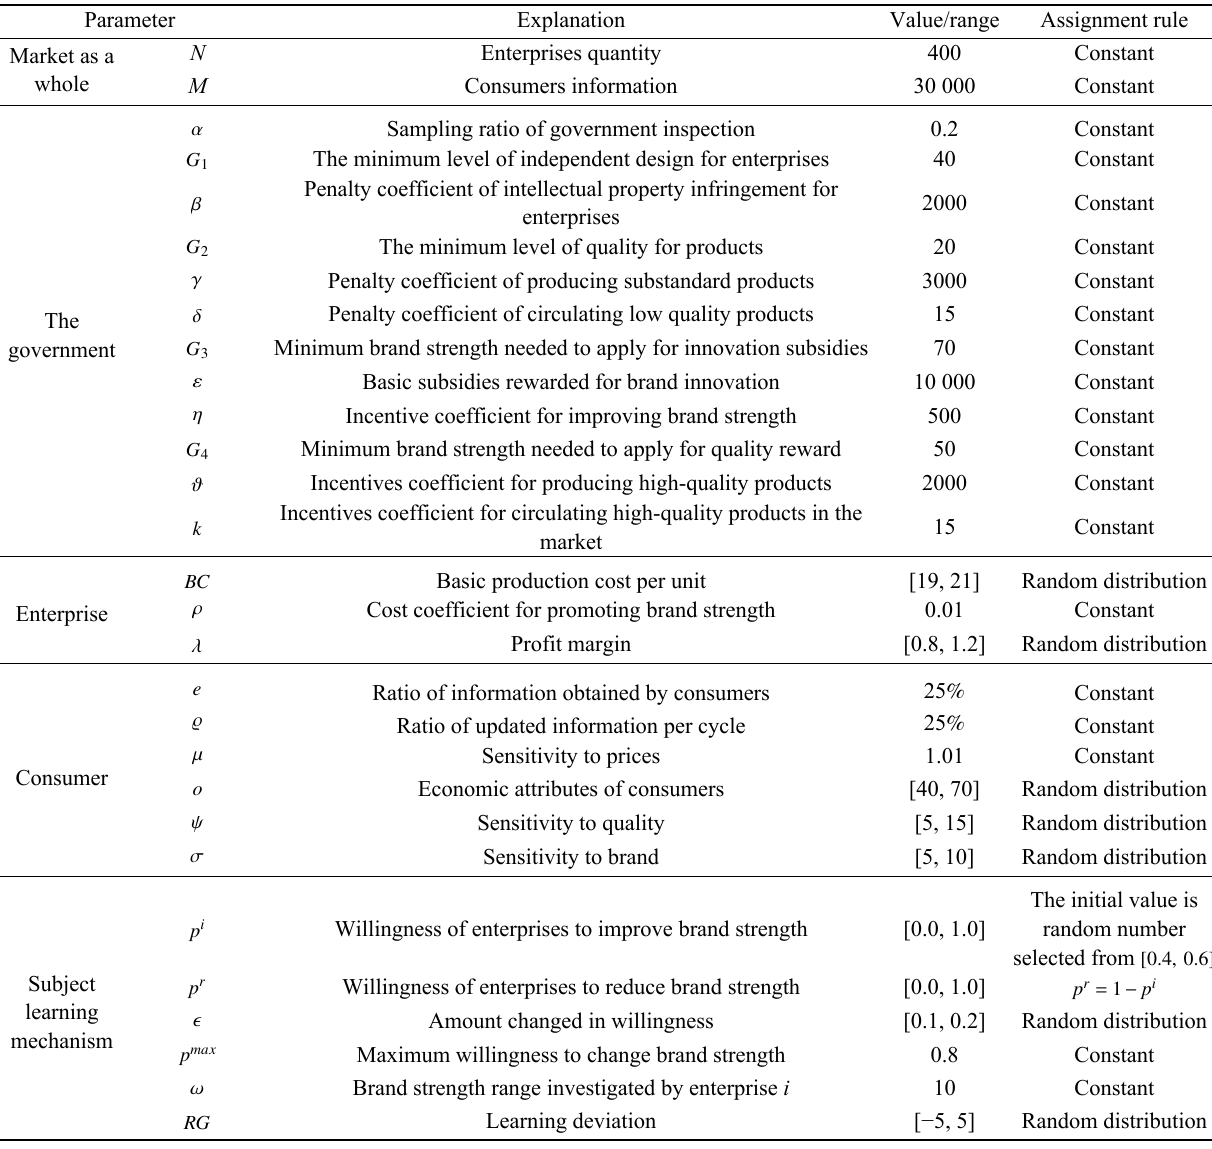
Table 3 Experimental parameter design, meaning, value range, and assignment rules.